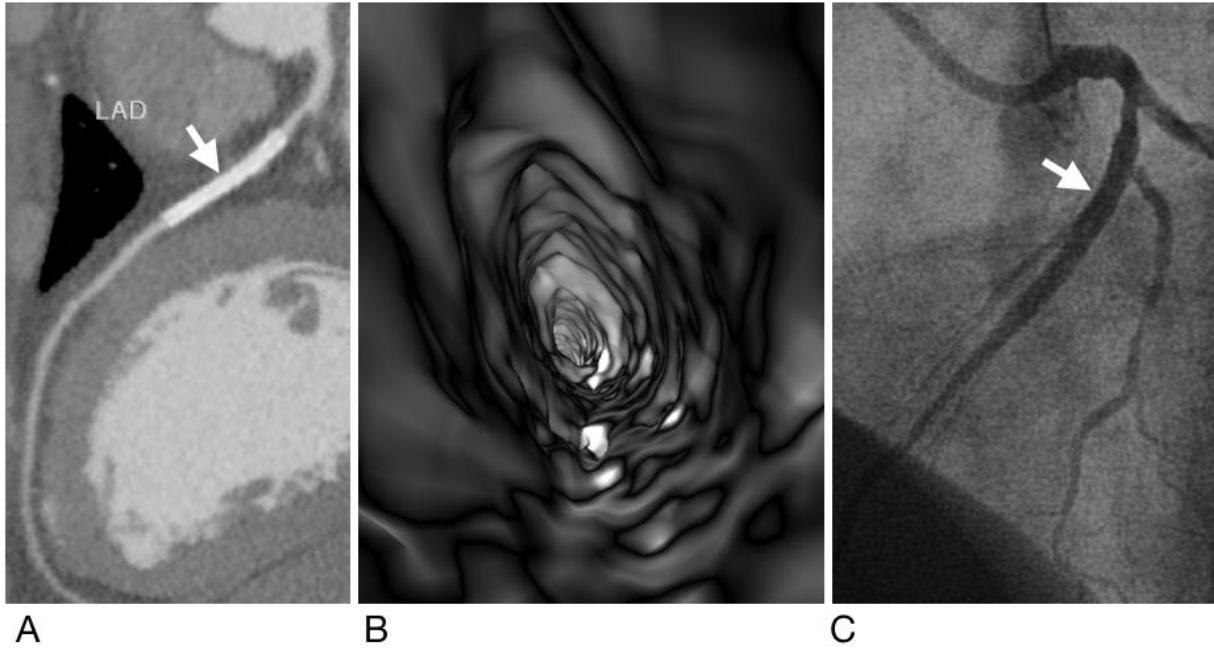
Figure 2. A case of true negative results for both CCTA and VIE. Subject is a 45-year-old woman with hypertension and type 2 diabetes mellitus and has a metallic stent (Xience V, 2.5 mm × 38 mm) (arrow) placed in the left anterior descending artery (LAD). Both CCTA ( A ) and VIE ( B ) showed patency of the stent without ISR, which was confirmed by ICA (arrow) ( C ).